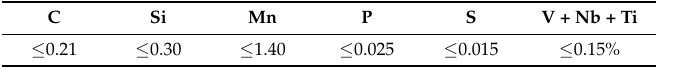
Table 1. Chemical compositions of J55 ERW steel pipe.